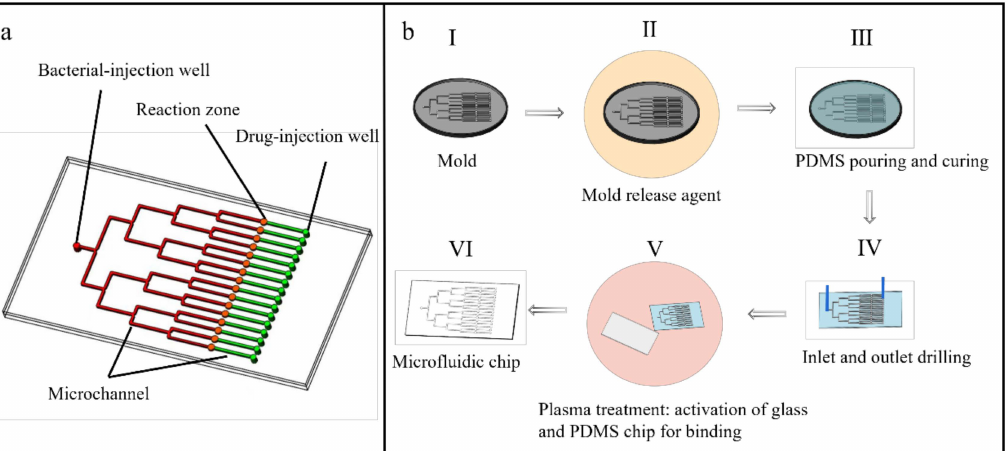
Figure 2. Structure and fabrication process of the microfluidic chip. ( a ) Diagram of the chip structure. The microfluidic chip contains three important zones: bacteria injection zone (red), drug-injection zone (green), and reaction zone (orange). ( b ) Fabrication of the microfluidic chip. (I) Manufacture of the chip mold on silicon wafer by photolithography. (II) Fumigation of release agent on the mold. (III) Pouring of PDMS mixed with curing agent onto the mold, followed by curing in a drying oven. (IV) Peeling the solidified PDMS from the mold and punching at the injection region. (V) Encapsulating the microfluidic chip by plasma bonding. Panel VI displays the completed